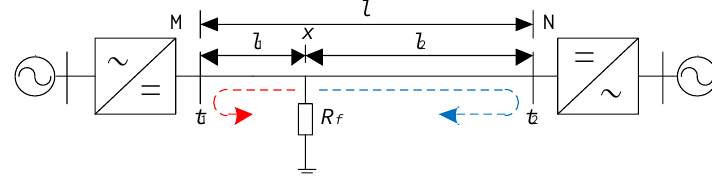
Figure 7. Schematic of traveling waves propagate in a two-terminal MMC-HVDC system.